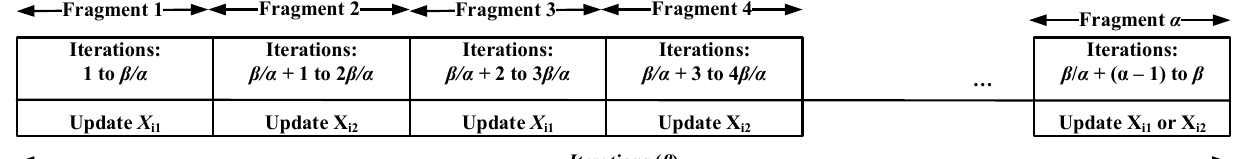
Figure 2. The proposed PSO α .